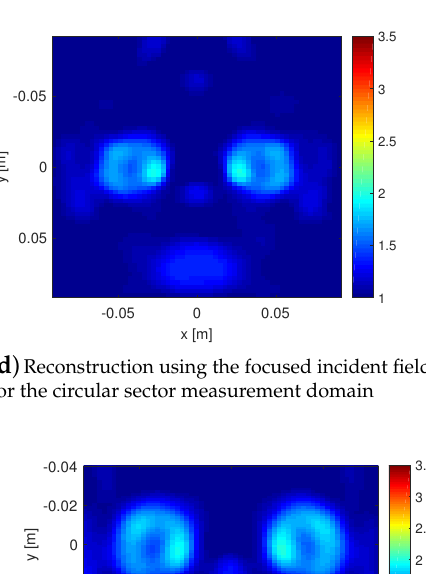
( a ) Reconstruction using the omnidirectional incident field for the full circular measurement domain